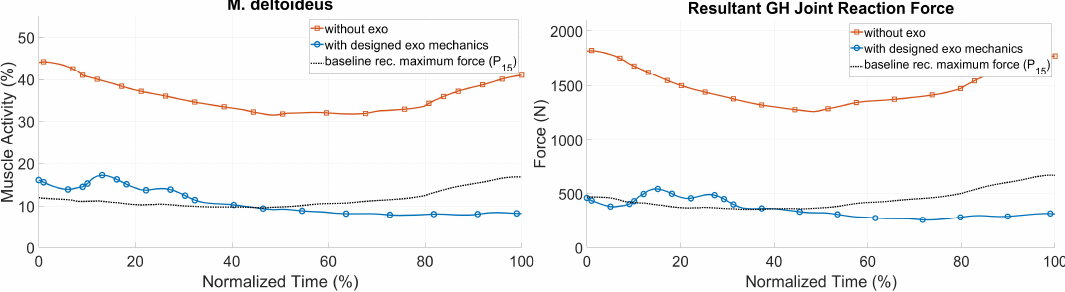
Figure 16. Biomechanical results for the push scenario for the muscle and joint loads of the right Figure16. Biomechanicalresultsforthepushscenarioforthemuscleandjointloadsoftherightshoulder. Int. J. Environ. Res. Public Health 2020 , 17 , x shoulder.